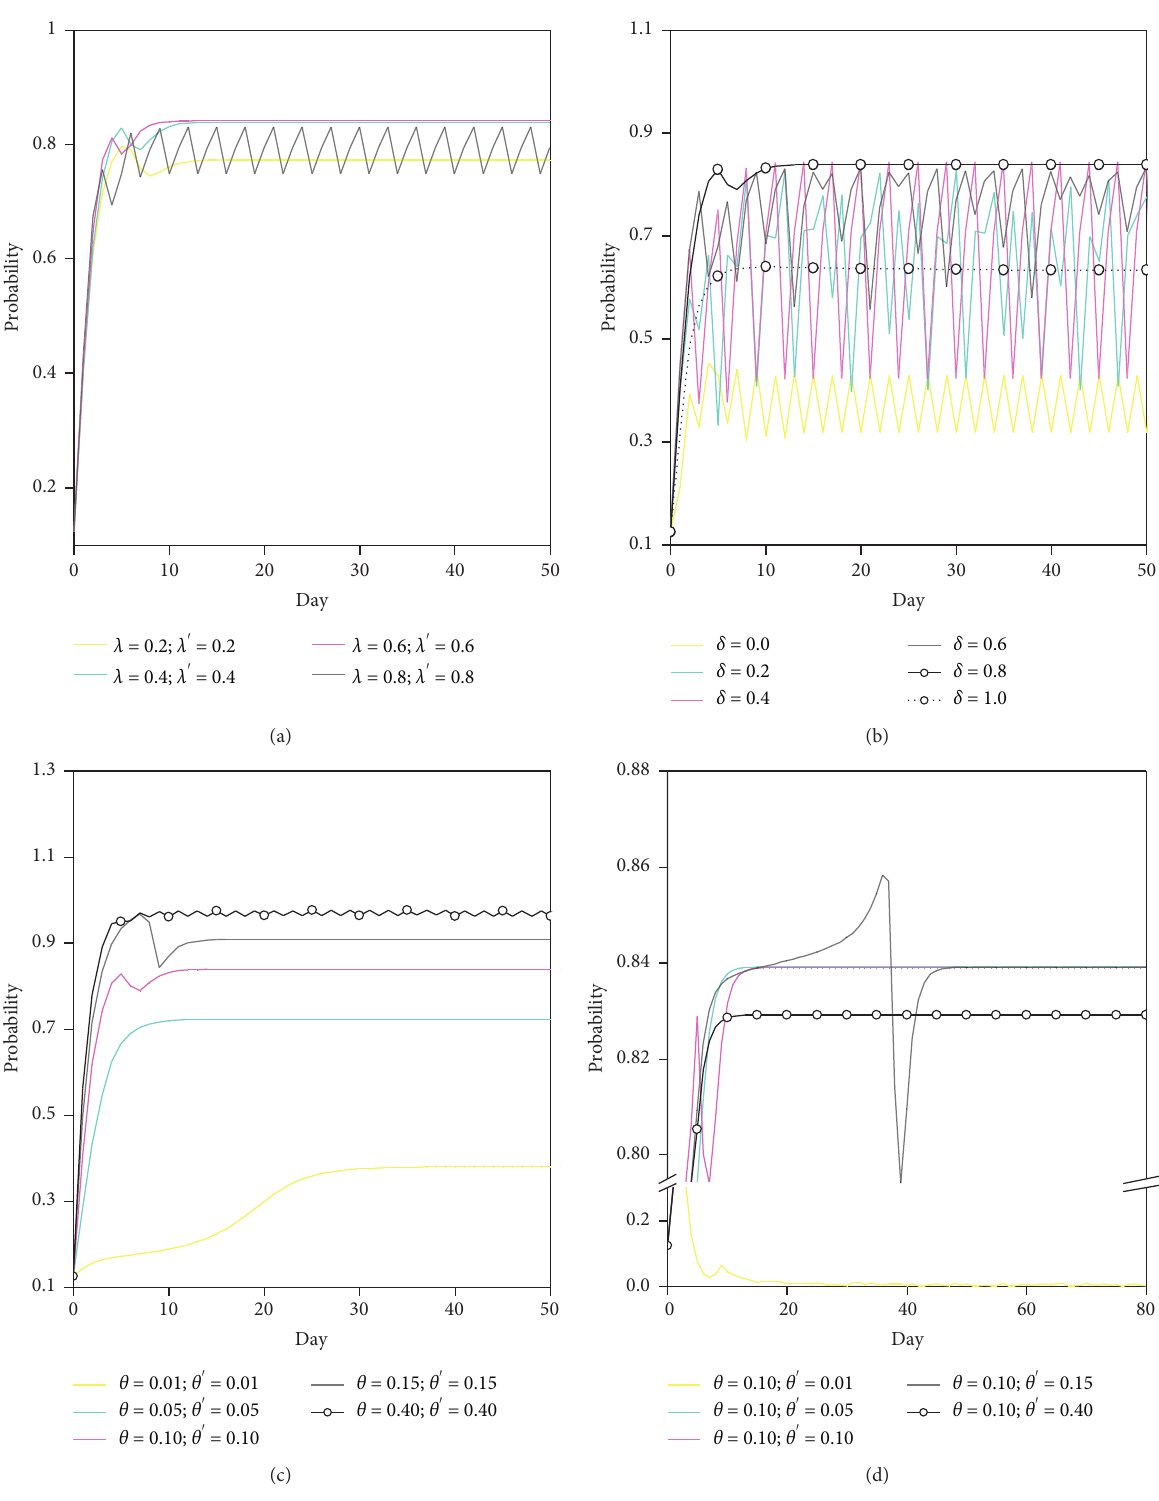
′ (b) δ , (c) θ � θ ′ , and (d) θ ≠ θ ′